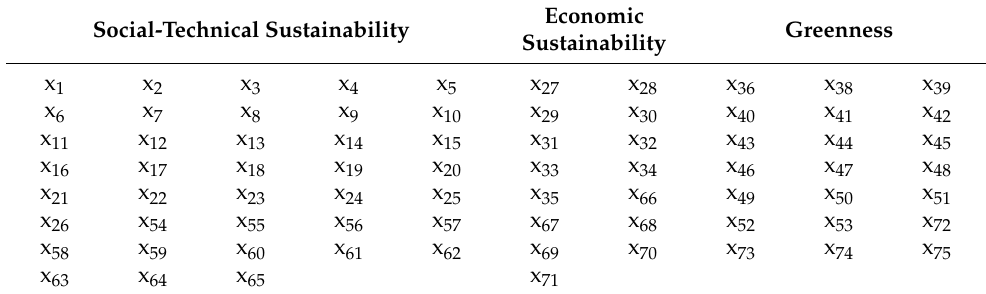
Table 7. A preliminary indicator set of steel structures.